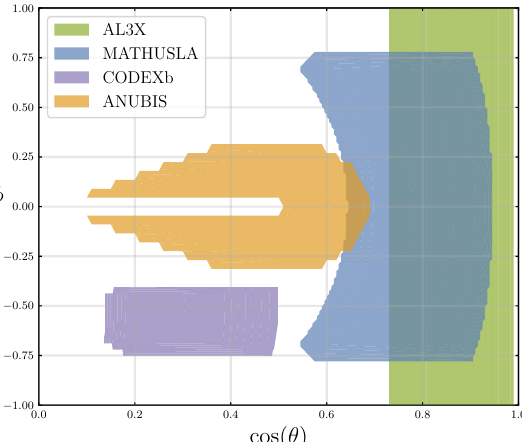
Figure 1 . Detector Coverage of the four most sensitive LLP experiments in angular space. Each area was estimated using the detector simulation of section 4. To achieve a clearer picture, CODEX- b was shifted in φ by − π/ 2 which is justified by the physics being φ -independent. AL3X covers the entire φ range ( 0 , 2 π ).